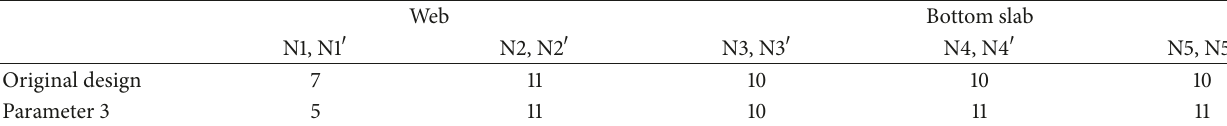
Table 2: Number of prestressed steel